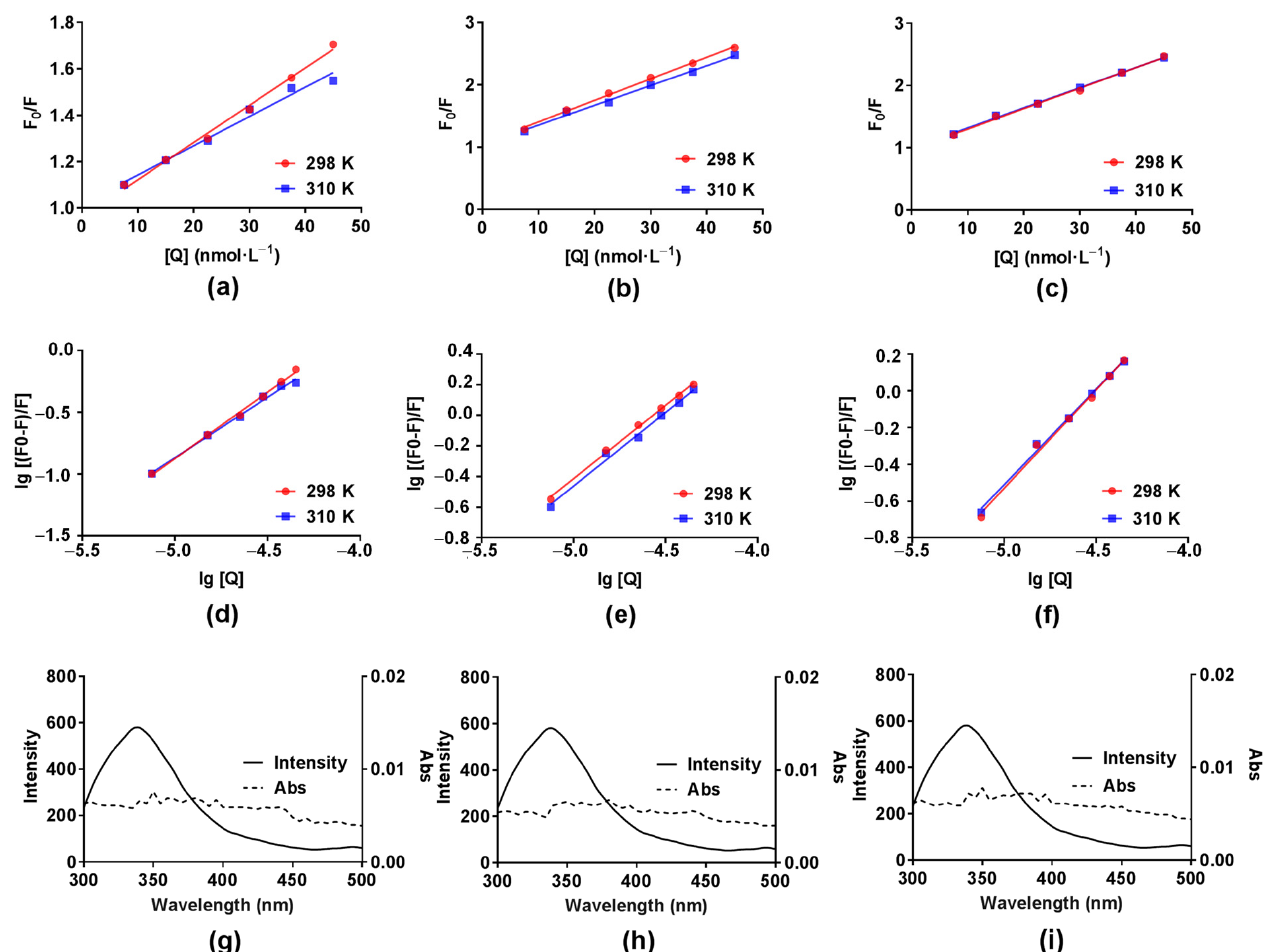
Figure 5. Stern-Volmer plots for COX2-DB2 ( a ), COX2-SC2 ( b ) and COX2-YB2 ( c ) at 298 K and 310 K; Double logarithmic plots for COX2-DB2 ( d ), COX2-SC2 ( e ) and COX2-YB2 ( f ) at 298 K and 310 K; The overlap between COX2 (5.0 × 10 − 8 mol ∙ L − 1 ) fluorescence spectra (solid line) and compounds DB2 ( g ), SC2 ( h ) or YB2 ( i ) (5.0 × 10 − 8 mol ∙ L − 1 ) absorbance spectra (short dot). Table 1. The Stern-Volmer quenching constant ( Ksv ), bimolecular quenching constant ( Kq ) and binding constant ( K A ) for the interaction of compounds DB2, SC2 and YB2 with COX2 at 298 K and 310 K. Compound